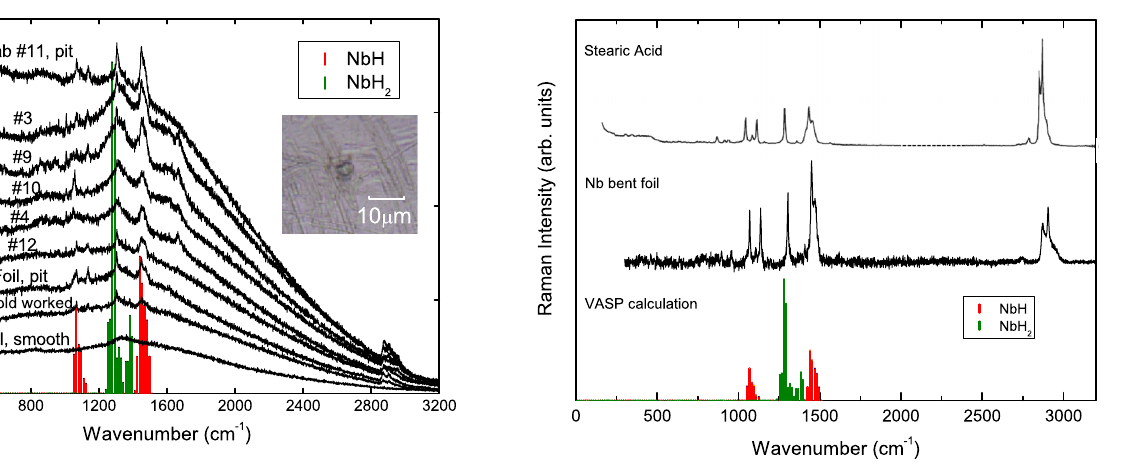
FIG. 6. Top: Raman spectrum of stearic acid [17]. Middle: Raman spectrum of a cold-worked foil stripped of background. Bottom: DFT calculations of NbH and NbH 2